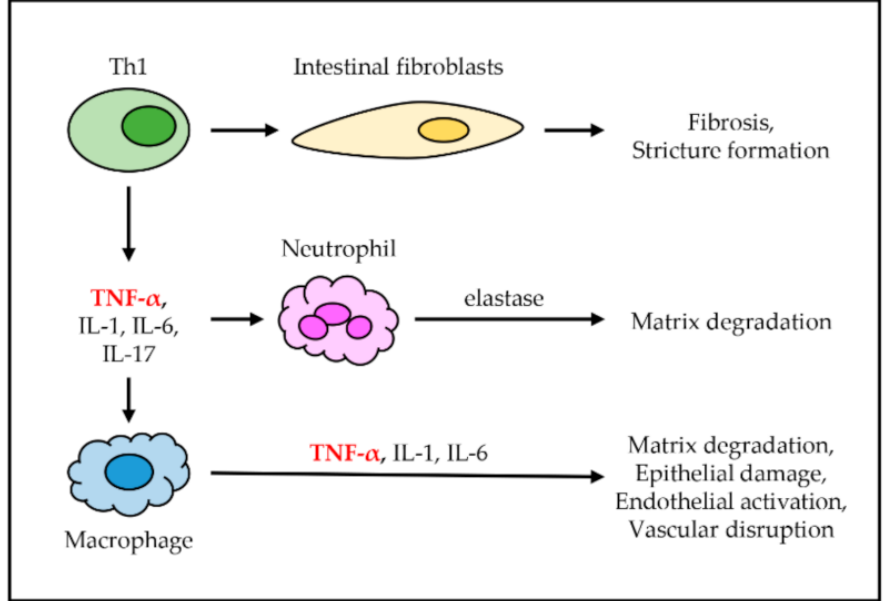
Figure 3. The role of TNF- α in inflammatory bowel disease (IBD). TNF- α is secreted from Th1 cells along with other cytokines. These cytokines cause the accumulation of immune cells, including intestinal fibroblasts, neutrophils, and macrophages in the gut. Intestinal fibroblasts cause fibrosis and stricture formation. Neutrophils secrete elastase, which causes intestinal matrix degradation. Macrophages produce more inflammatory cytokines, which causes intestinal matrix degradation, epithelial damage, endothelial activation, and